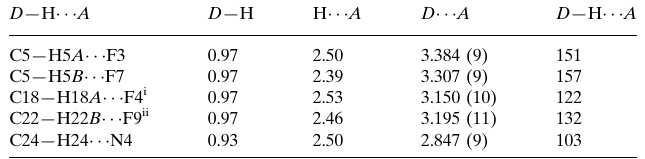
Hydrogen-bond geometry (A˚ , (cid:2)